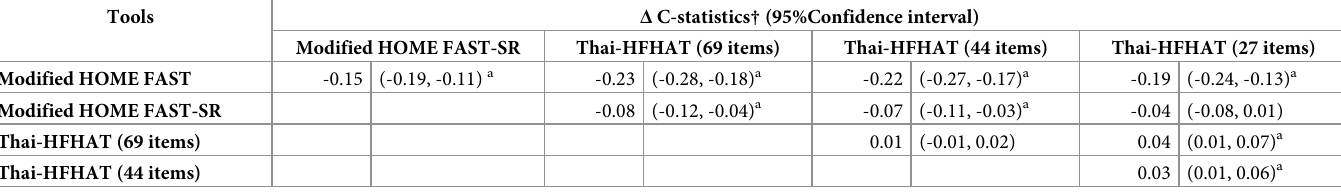
Table 4. Comparison of predictive validity among five home fall hazard assessment